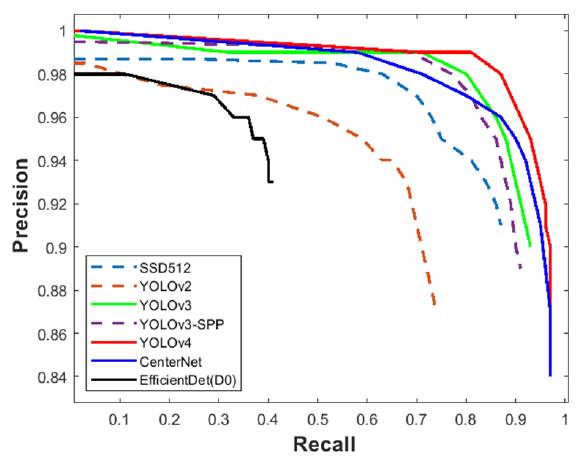
Figure 6. Comparison of precision/recall curves in custom